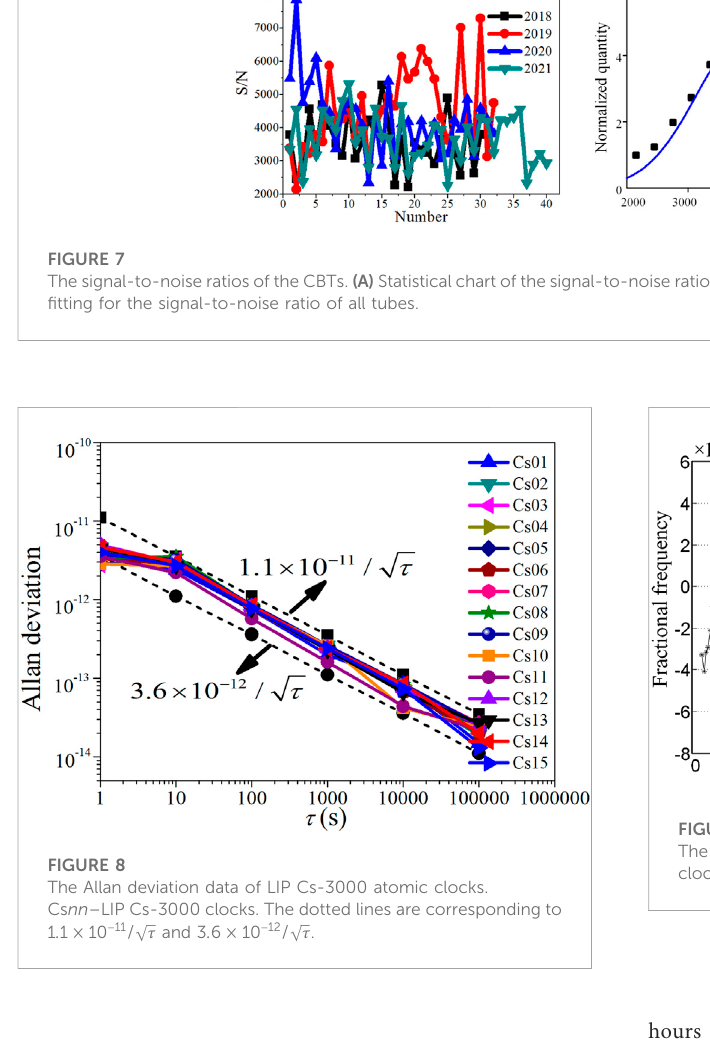
deviation data of 15 cesium atomic clocks during 15-days